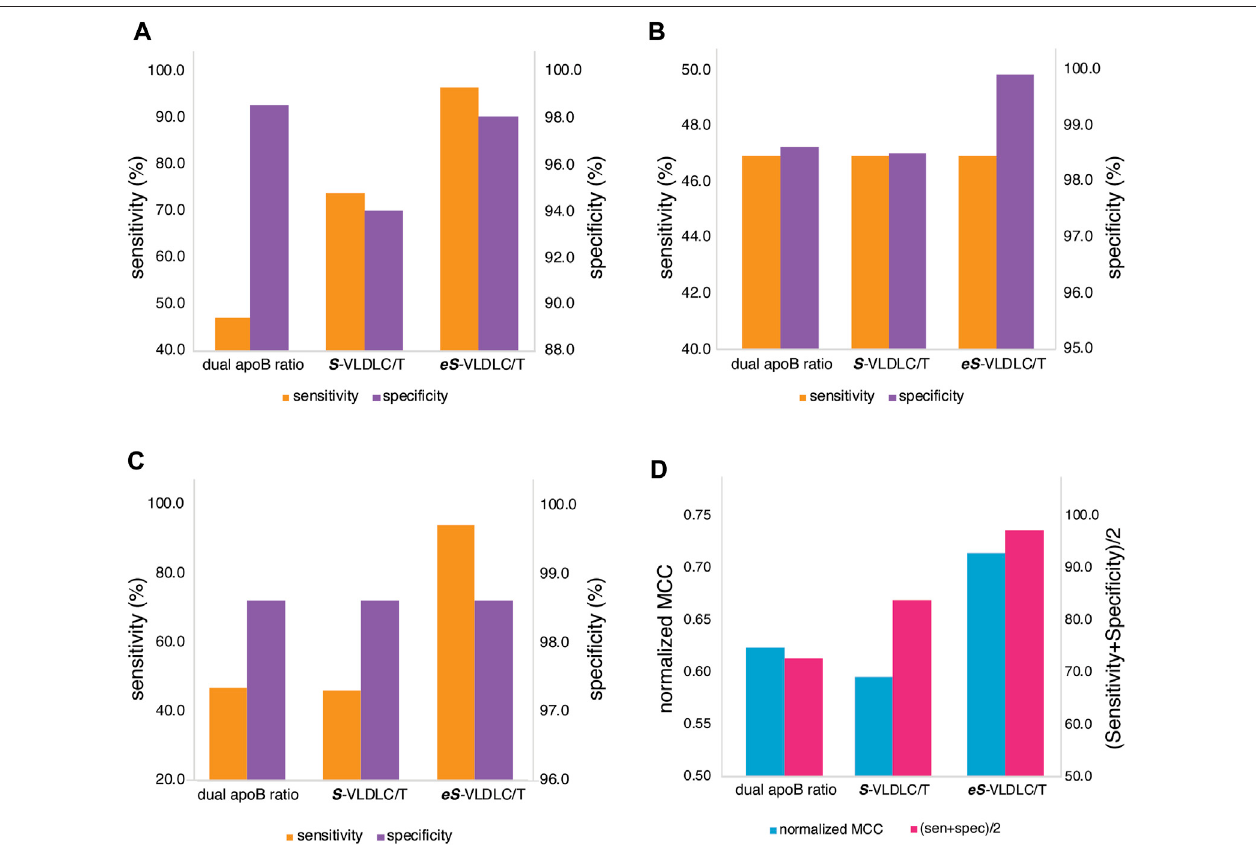
FIGURE5| Comparison oftestaccuracyforHLP3classi fi cation. Classi fi cation accuracyinthevalidationdataset(N=12,405)bysensitivity (orange)andspeci fi city (purple) for the dual apoB ratio method, the Sampson VLDL-C/TG ( S -VLDL-C/T), and enhanced Sampson VLDL-C/TG ( eS -VLDL-C/T) methods are shown for the optimal cut-points (A) , after adjustment to match the dual apoB ratio sensitivity (B) , and after adjustment to match the dual apoB ratio speci fi city (C) . The normalized MCC score (blue) and the average of sensitivity and speci fi city (sen + spec/2; pink) are shown for the optimal cut-points (D) .